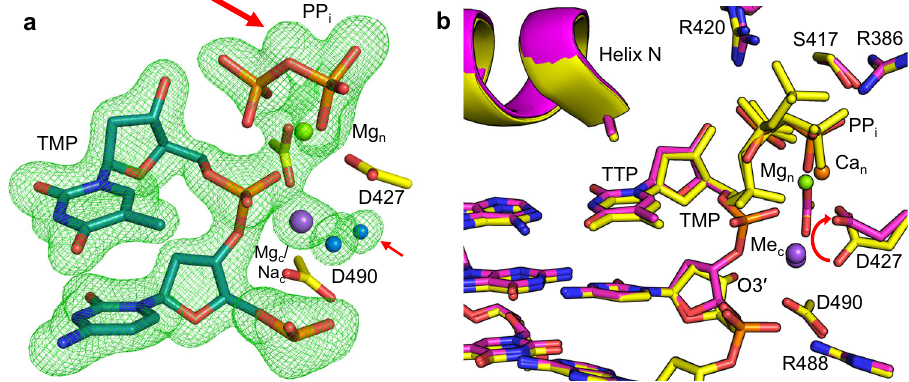
Fig. 3 Matched Mg 2 + -product state ternary complex. a Mg c is replaced by Na c (purple sphere) upon O3´ – P α bond formation resulting in loss of metal coordination with Asp427 and rotation of the latter ~90° into a product conformation. Mg 2 + -dependent product formation is accompanied by partial dissociation of P1 (former P β of TTP) of product PP i , as indicated by the appearance of simulated annealing (F o -F c ) omit density (3 σ , carve radius 2.0 Å) shown by the larger red arrow. DNA is displayed in cyan stick representation, side chains are in yellow, water molecules are blue spheres. An Na c coordinating water molecule is indicated by a smaller red arrow. b Comparison of matched Ca 2 + -GS and Mg 2 + product complexes. Changes in the primer terminal nucleotide sugar (O3´) and rotation of Asp427 (curved red arrow) are observed. Ca 2 + -GS complex is shown in yellow, PS Mg in magenta. Residues 386 – 494 (palm domain) of each structure were